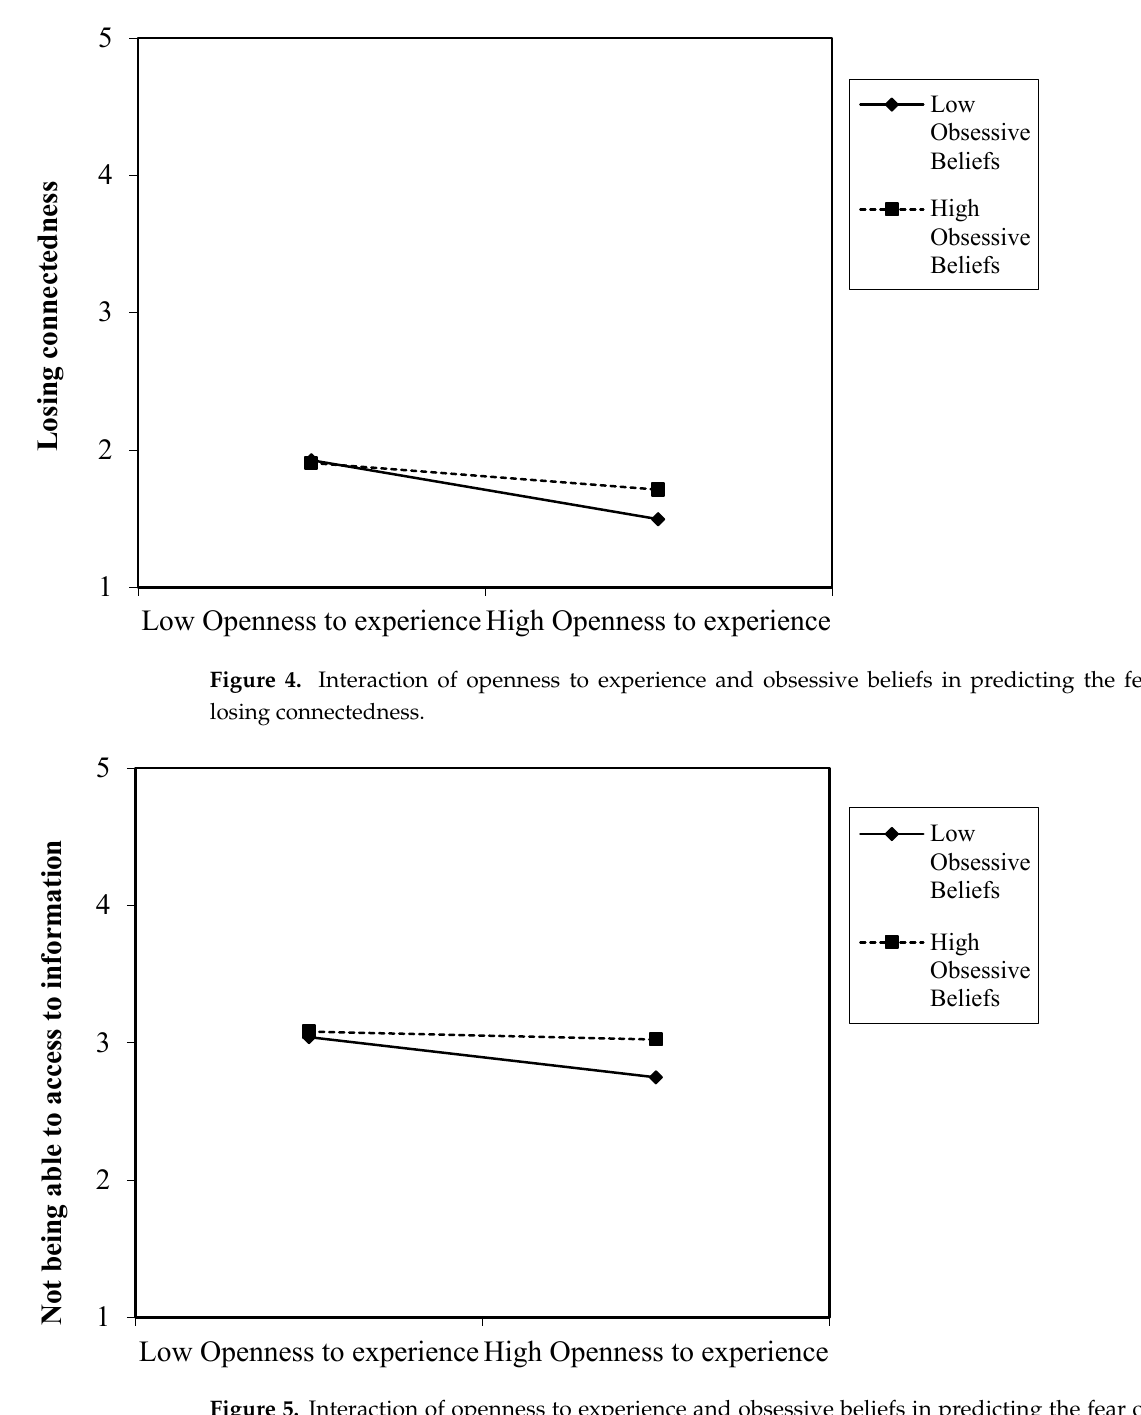
Figure 3. Interaction of openness to experience and obsessive beliefs in predicting the fear of not being able to communicate.